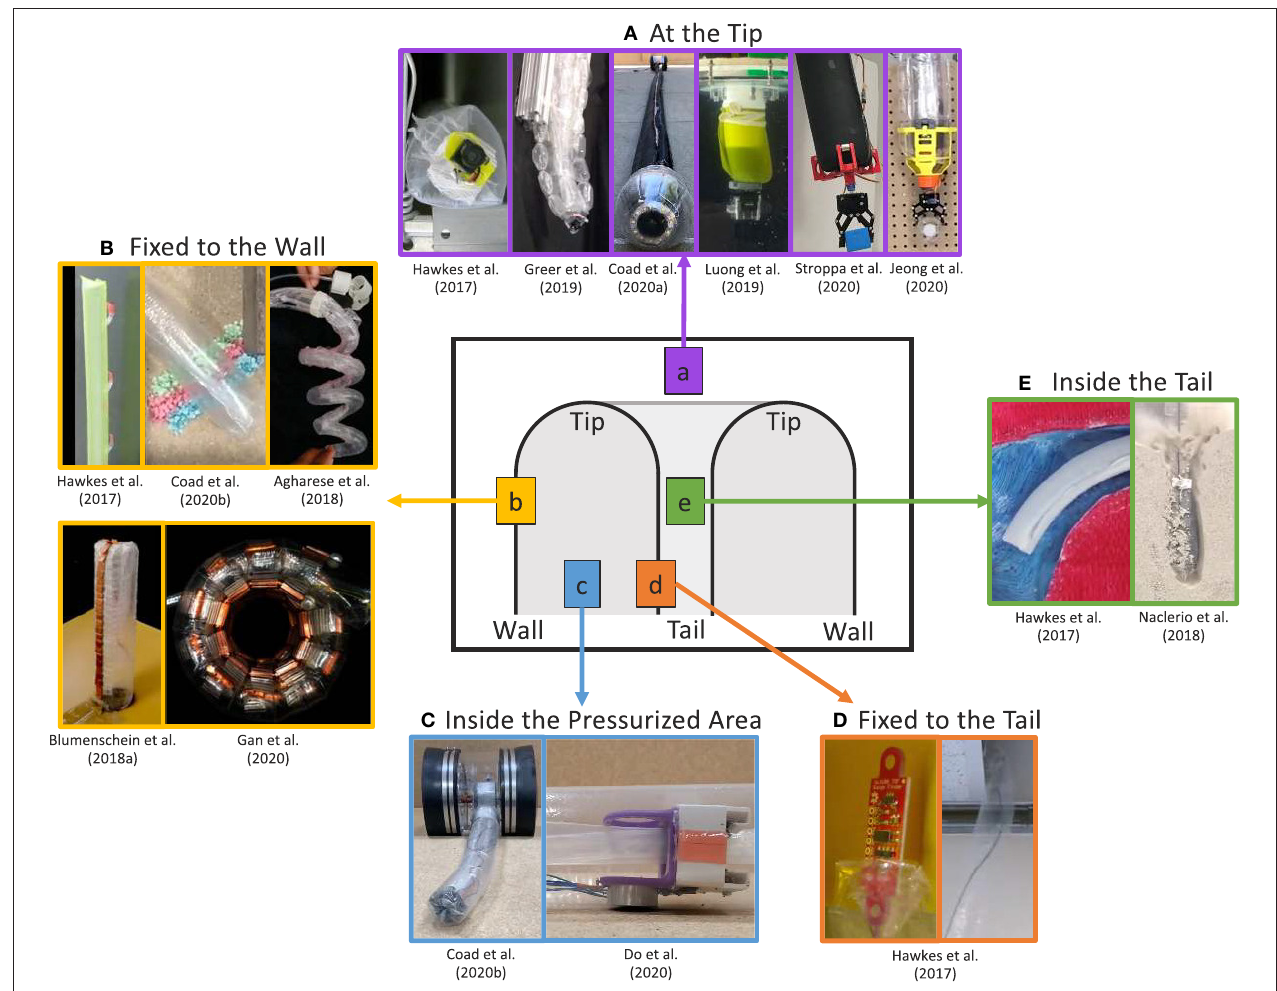
FIGURE 5 | Five locations for mounting sensors and tools around the body of an everting vine robot: (A) at the tip, (B) fixed to the wall, (C) inside the pressurized area, (D) fixed to the tail, and (E) inside the tail. Modified from Hawkes et al. (2017). Reprinted with permission from AAAS. Modified from Greer et al. (2019). The publisher for this copyrighted material is Mary Ann Liebert, Inc. publishers. Modified from Coad et al. (2020a) © IEEE 2020, Luong et al. (2019) © IEEE 2019, Stroppa et al. (2020) © IEEE 2020, Jeong et al. (2020), Coad et al. (2020b) © IEEE 2020, Agharese et al. (2018) © IEEE 2018, Blumenschein et al. (2018a) © IEEE 2018, Gan et al. (2020) © IEEE 2020, Do et al. (2020) © IEEE 2020, and Naclerio et al. (2018) © IEEE